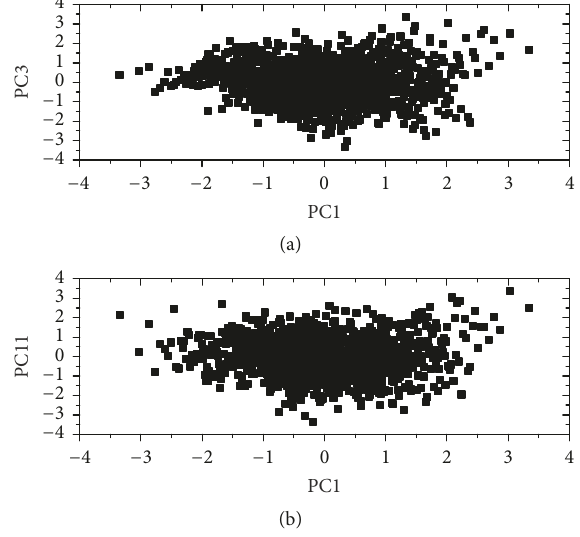
Figure 5: Scatter-plots of PC1 versus PC3 (a) and PC1 versus PC11 (b). The marginal pdfs have been